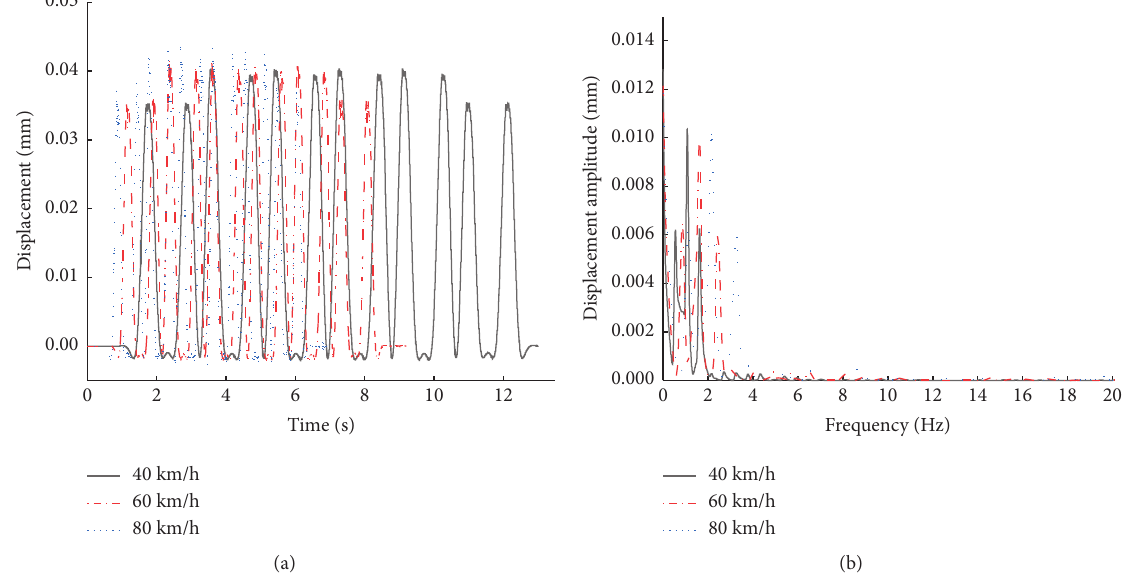
Figure 6: Vertical displacement (a) time-history curve and (b) amplitude-frequency curve of right monitoring point of trackbed at different